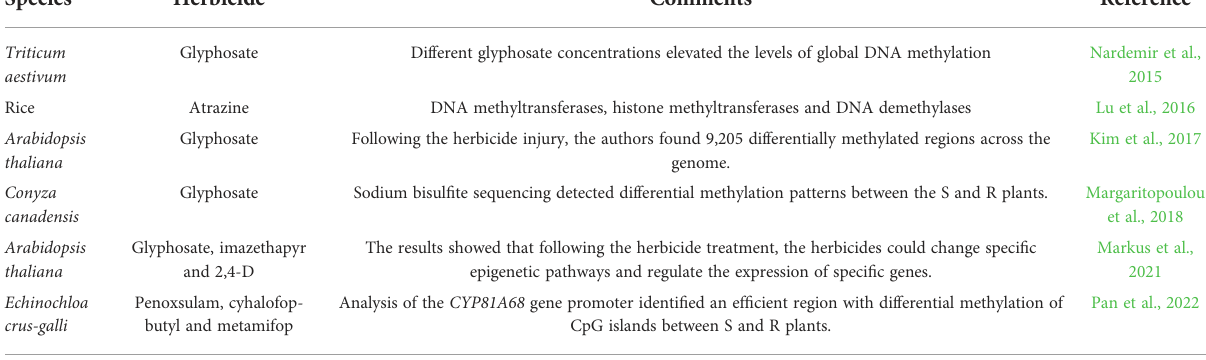
TABLE 1 The list of epigenetics-based research works related to herbicide sensitivities.